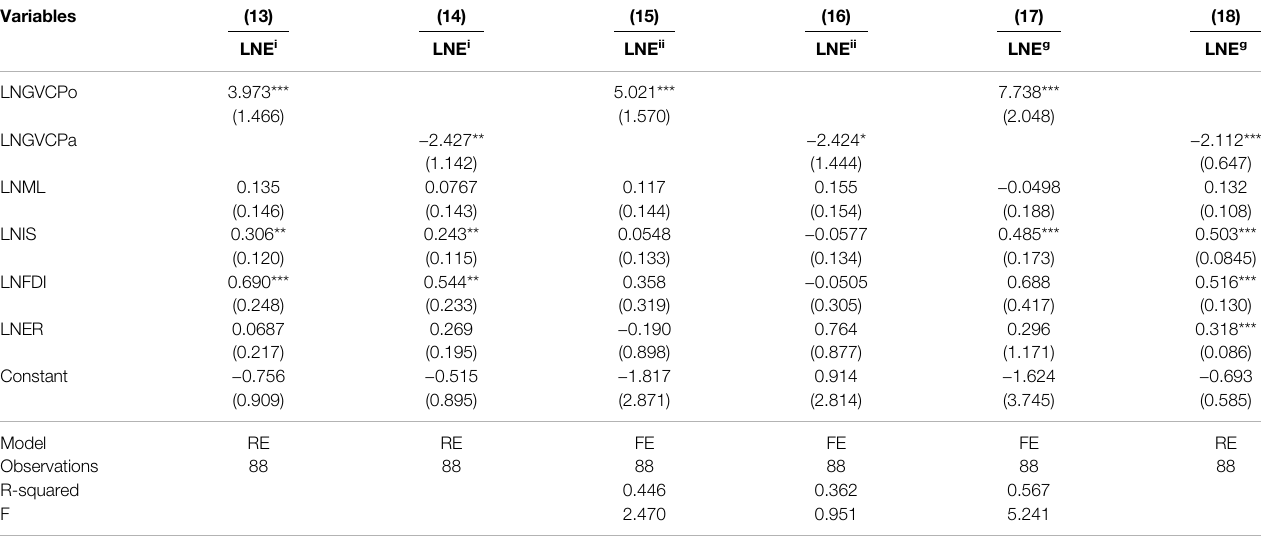
TABLE 5 | Empirical results of the impact of GVC embeddedness on the general innovation value chain.